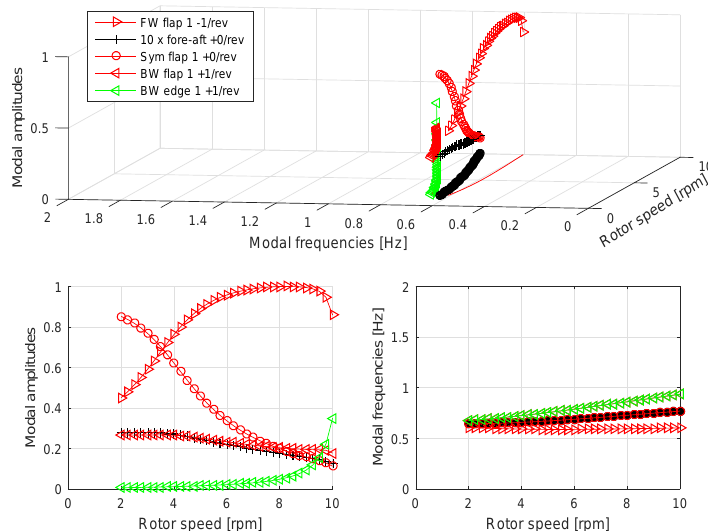
Figure 9. Harmonic modal components for the three-bladed turbine mode dominated by forward whirling (FW) of the rotor in the first flapwise DOF across the rotor speed range. Plot layout as in Fig. 5.